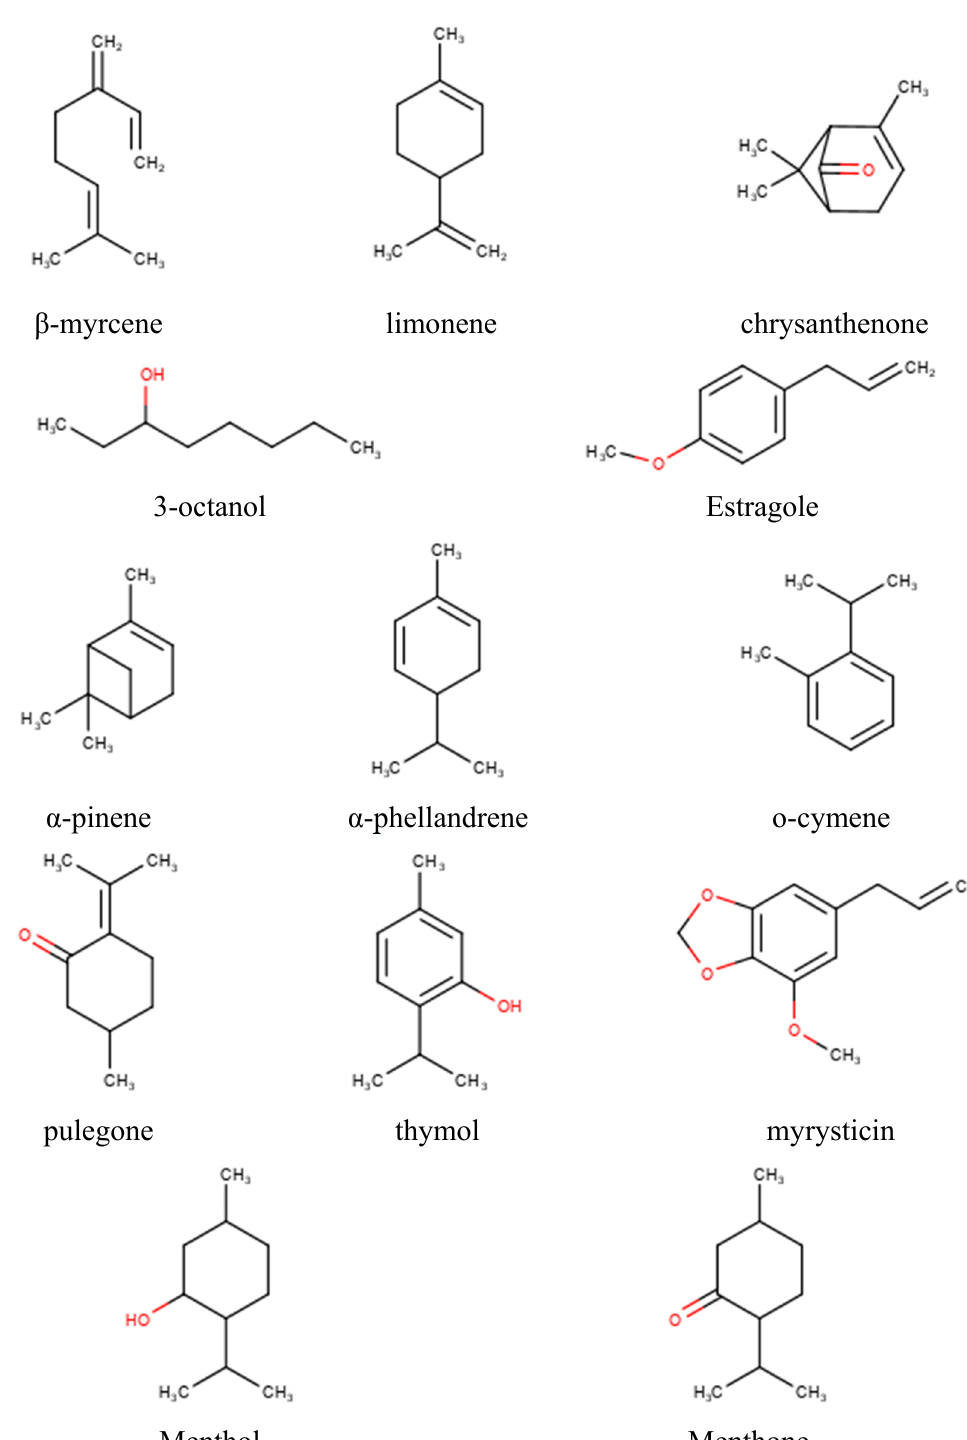
Figure 7. Chemical structures of the most important chemical components.